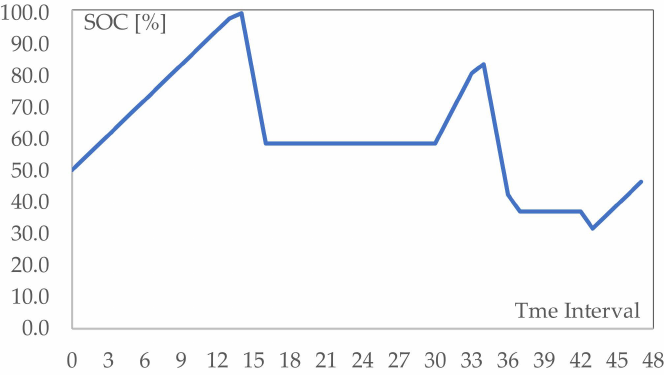
Figure 7. SOC profile for the mobility pattern